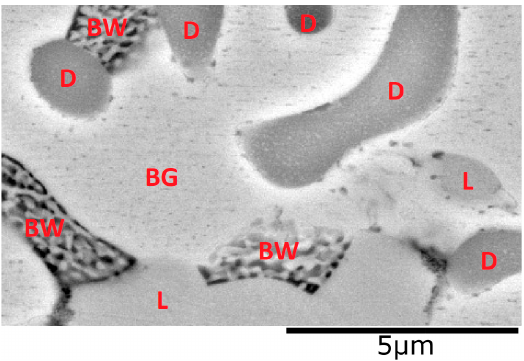
Figure 3. Microscopic image (a section).